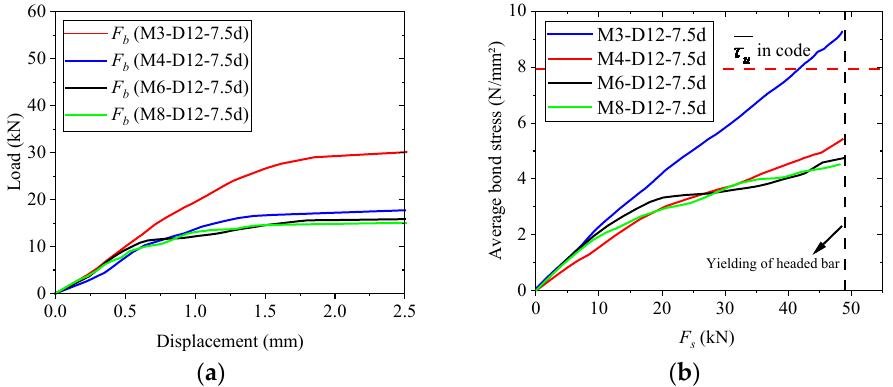
Figure 25. Bond behavior with different head size ( a ) Bond force; ( b ) Average bond stress.